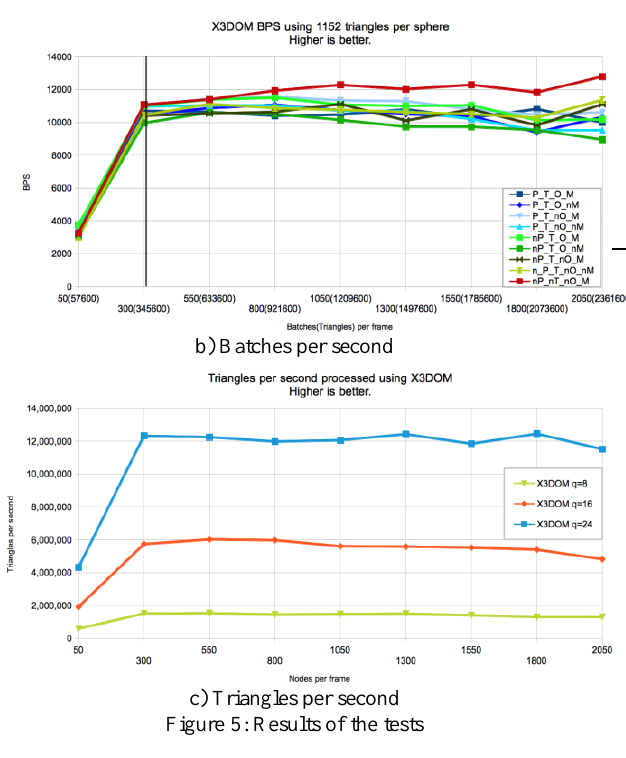
Table 1: Performance results using real